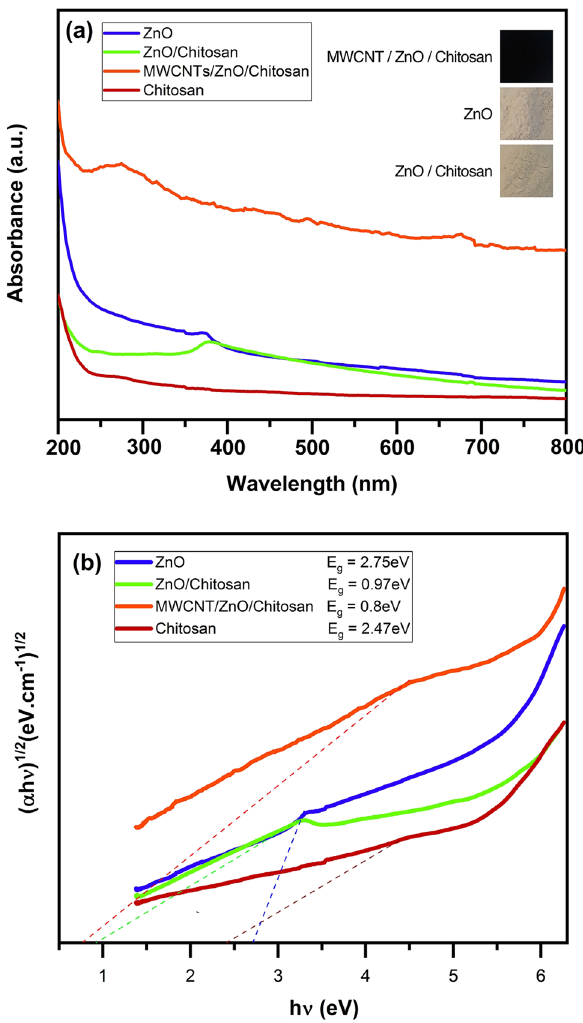
Figure 8. ( a ) UV–Vis diffuse reflecting spectra, ( b ) the bandgap energies of ZnO, Chitosan, ZnO/Chitosan and